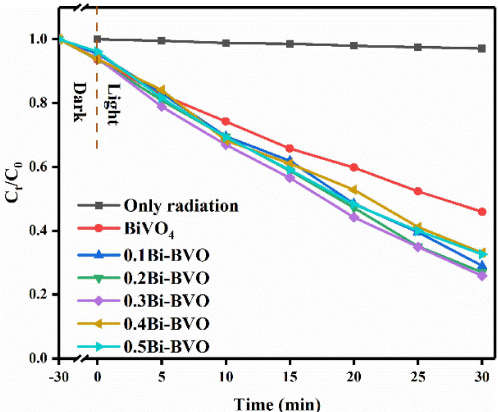
Figure 5. Photocatalytic degradation of ciprofloxacin (CIP) (reaction volume: 100 mL, initial CIP concentration: 10 mg/L, catalyst dose: 0.1 g, and temperature: 20 ◦ C). Table 1. Rate constant ( k ), and R 2 values for the degradation of ciprofloxacin.